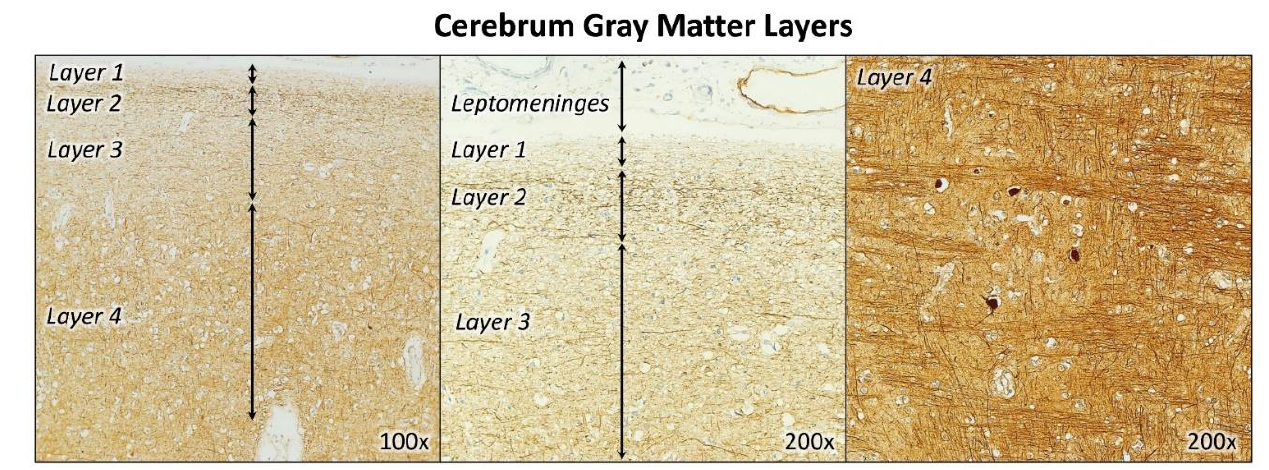
Figure 6. Microscopic images of the cerebrum with immunohistochemical stain for neurofilament showing a 4-layered gray matter. The superficial layer (layer 1) was paucicellular and contained few primarily small neurons. This outermost layer is the molecular layer that contains Cajal-Retzius neurons. The axonal density was reduced, and axons ran in a haphazard manner. The second layer (layer 2) was more adequately populated; however, the neurons were disorganized and displayed small and large pyramidal neurons with bland nuclear morphology. Most axons ran perpendicular to the surface. The third appreciable layer (layer 3) was again hypocellular; neuroepithelial cells were present and neurons were sparse. The fourth layer (layer 4) displayed diffuse vacuolation and was more densely cellular albeit disorganized. It showed axons organized in groups and separated by neuropil, which were either faintly or darkly stained. No heterotopic neurons were seen in the underlying pale and decreased white matter (Neurofilament IHC stain; 100 × and 200 × magnification).